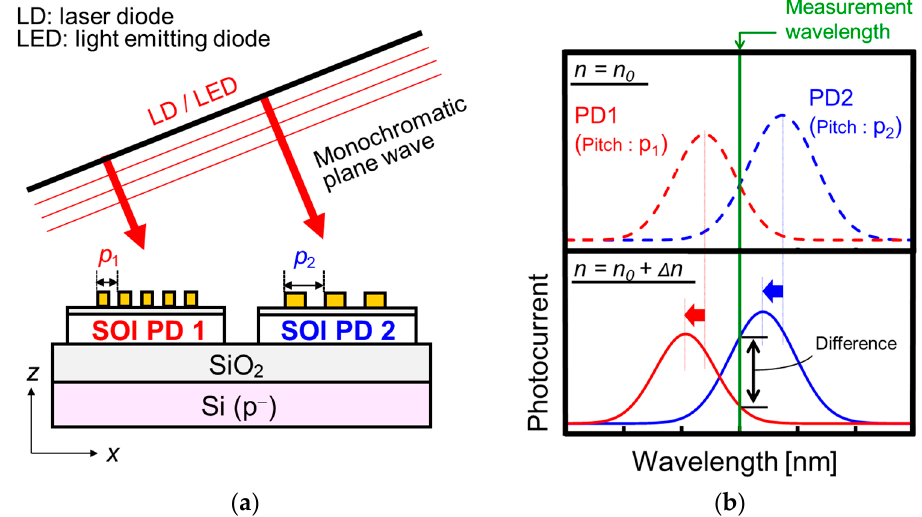
Figure 7. ( a ) Schematic of optical system and ( b ) operation principle for single-wavelength dual photodiode (PD) method.